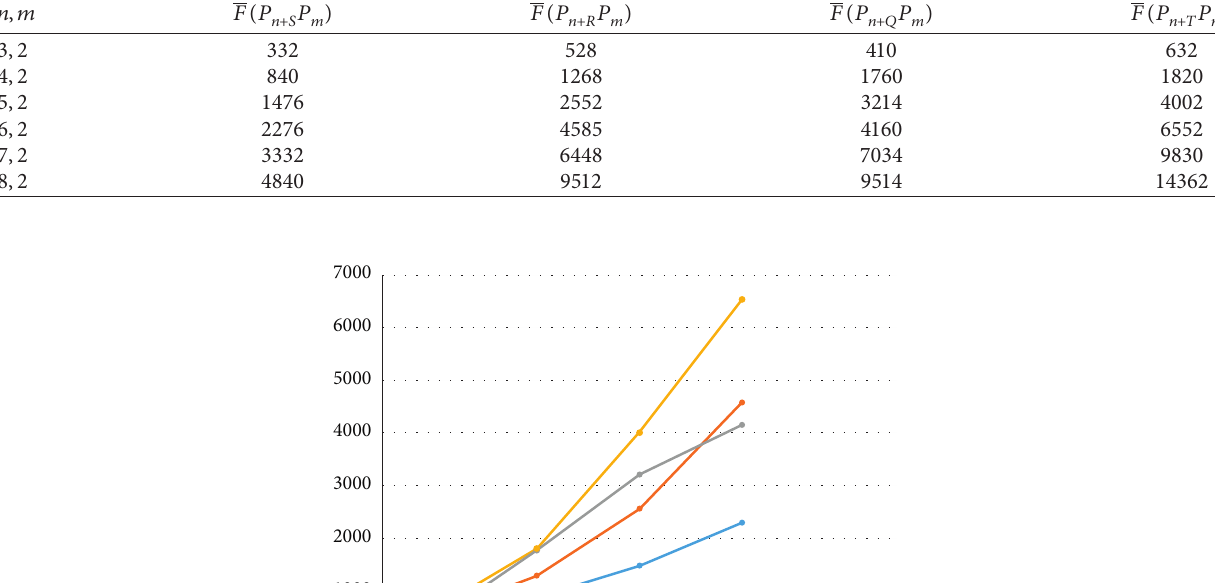
Table 1: For two graphs, H